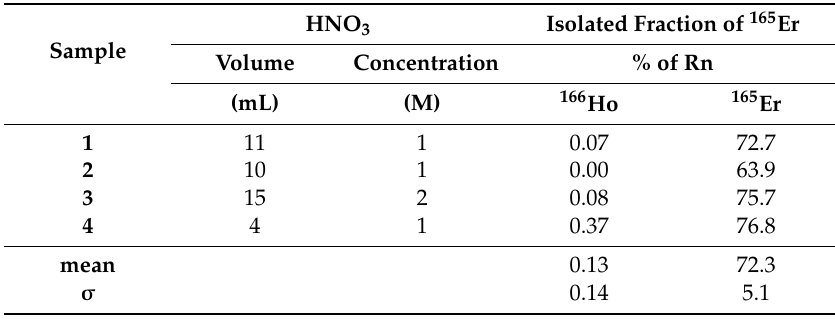
Table 3. % of 165 Er and 166 Ho in isolated fraction against all fractions.